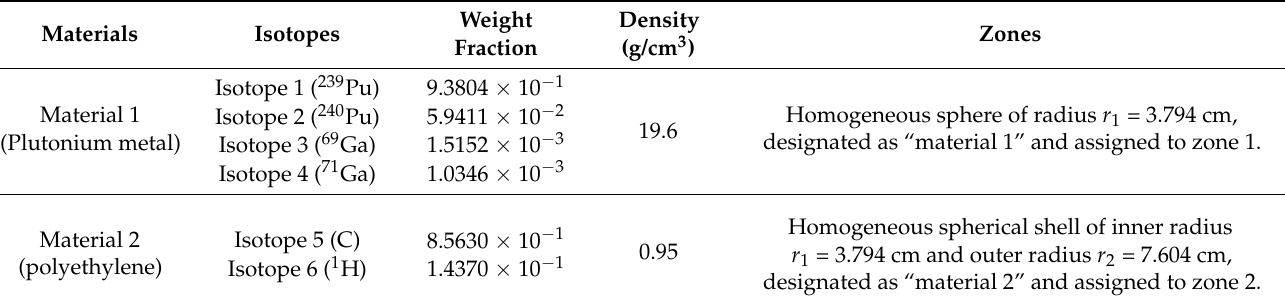
Table 1. Dimensions and material composition of the PERP benchmark